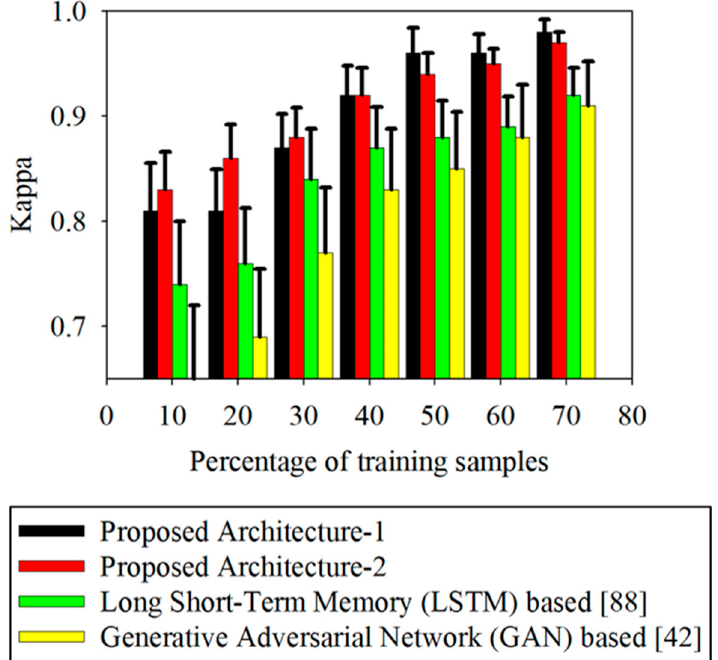
Figure 7. Comparison of classifiers with respect to varying percentages of training samples.